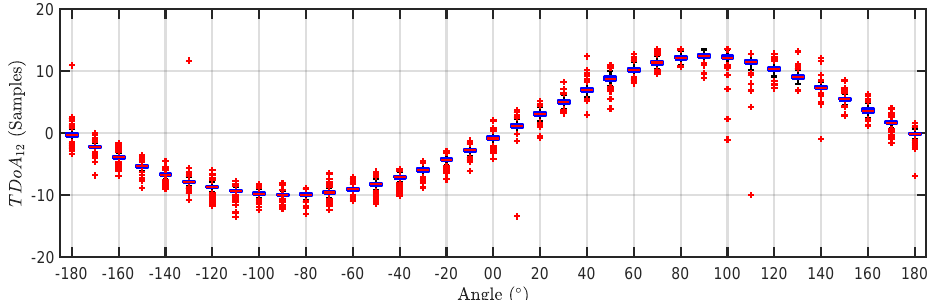
Figure 14. Box plot of the time differences of arrival versus angle of rotation for the pulses generated by source 1 in 3D localization.